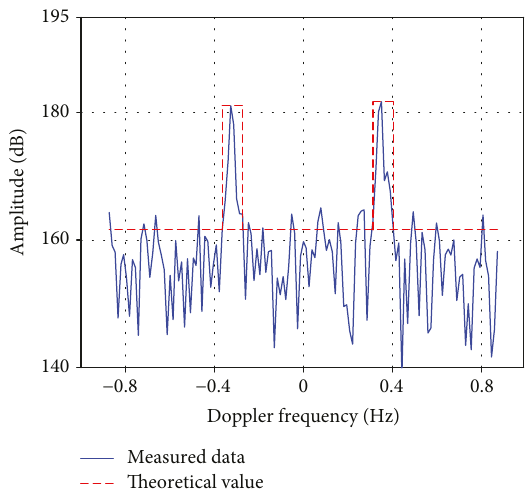
Figure 15: Comparison of the broadening value of the fi rst-order sea clutter.